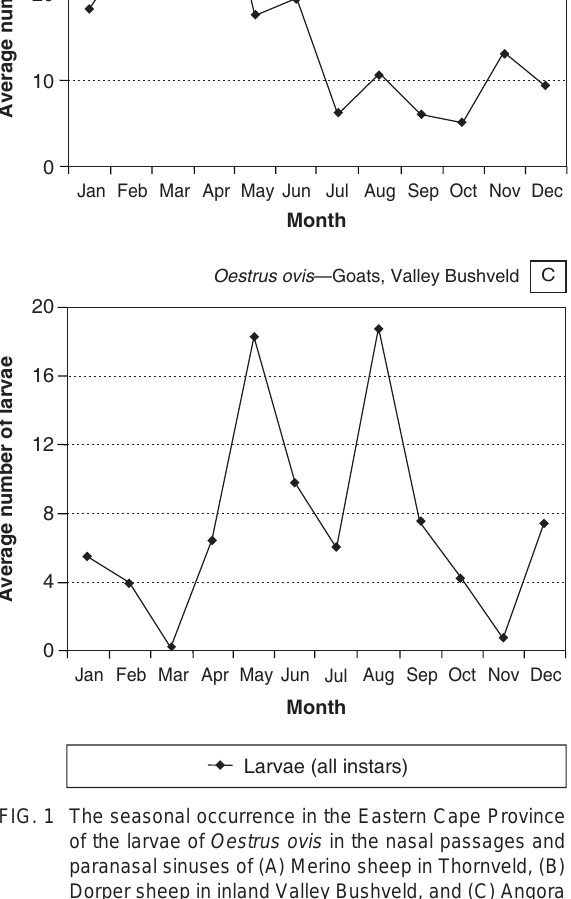
FIG. 1 The seasonal occurrence in the Eastern Cape Province of the larvae of Oestrus ovis in the nasal passages and paranasal sinuses of (A) Merino sheep in Thornveld, (B) Dorper sheep in inland Valley Bushveld, and (C) Angora and Boer goats in Valley Bushveld on the coastal